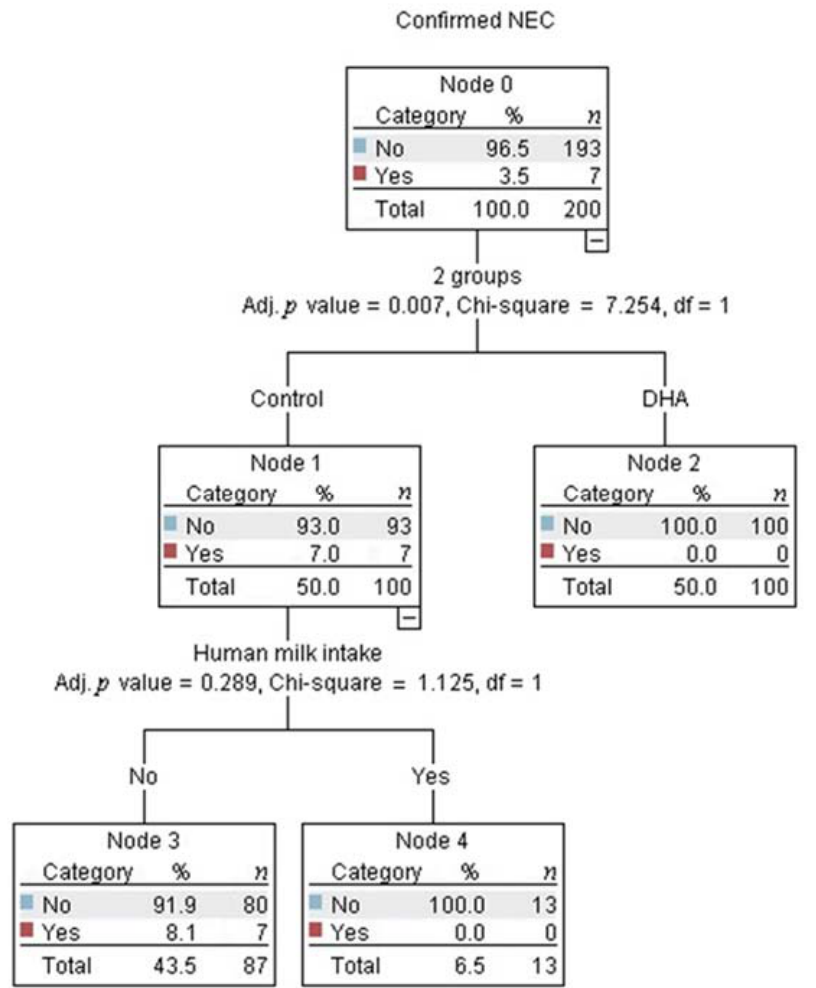
Figure 3. The decision tree obtained from the Chi-square automatic interaction detection multiple regression analysis showed that no infants in the control group who received any volume of human milk developed necrotizing enterocolitis